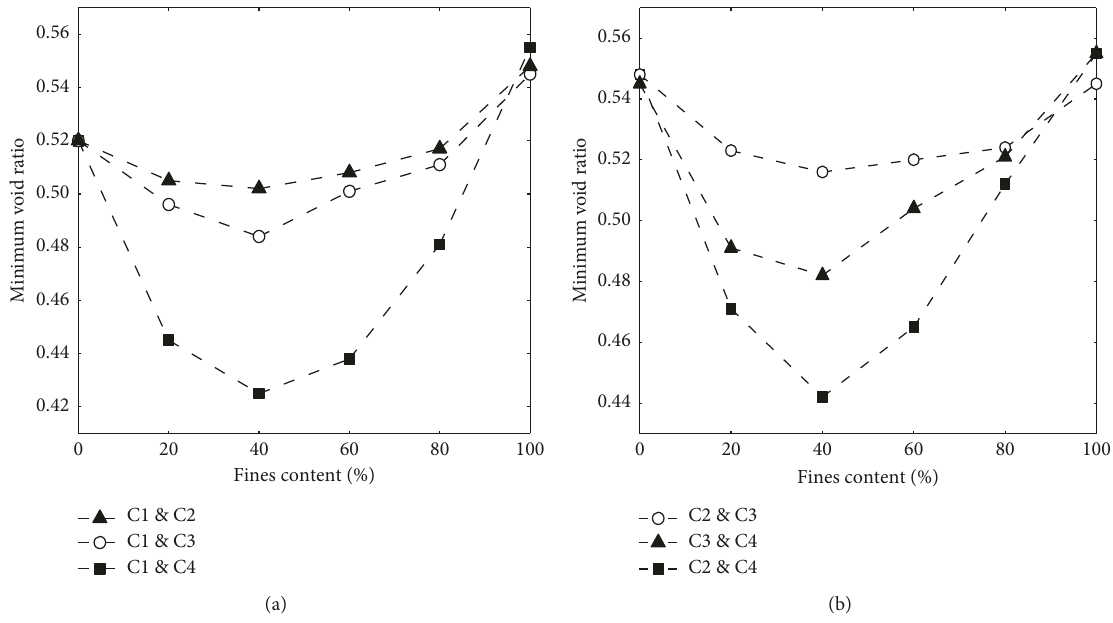
Figure 10: Measured minimum void ratios versus fines content for alternative material mixtures (SC and SC).